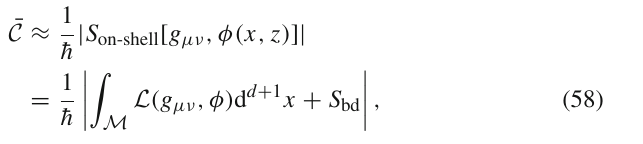
Fig. 5 a In CA conjecture, the two disconnected time slices t L and t R are both infinitely large. We first assume that t L and t R are finite but large enough intervals. b in the Lorentzian case, when the two-side boundary are large enough, the entanglement wedge of t L ∪ t R is just its WdW